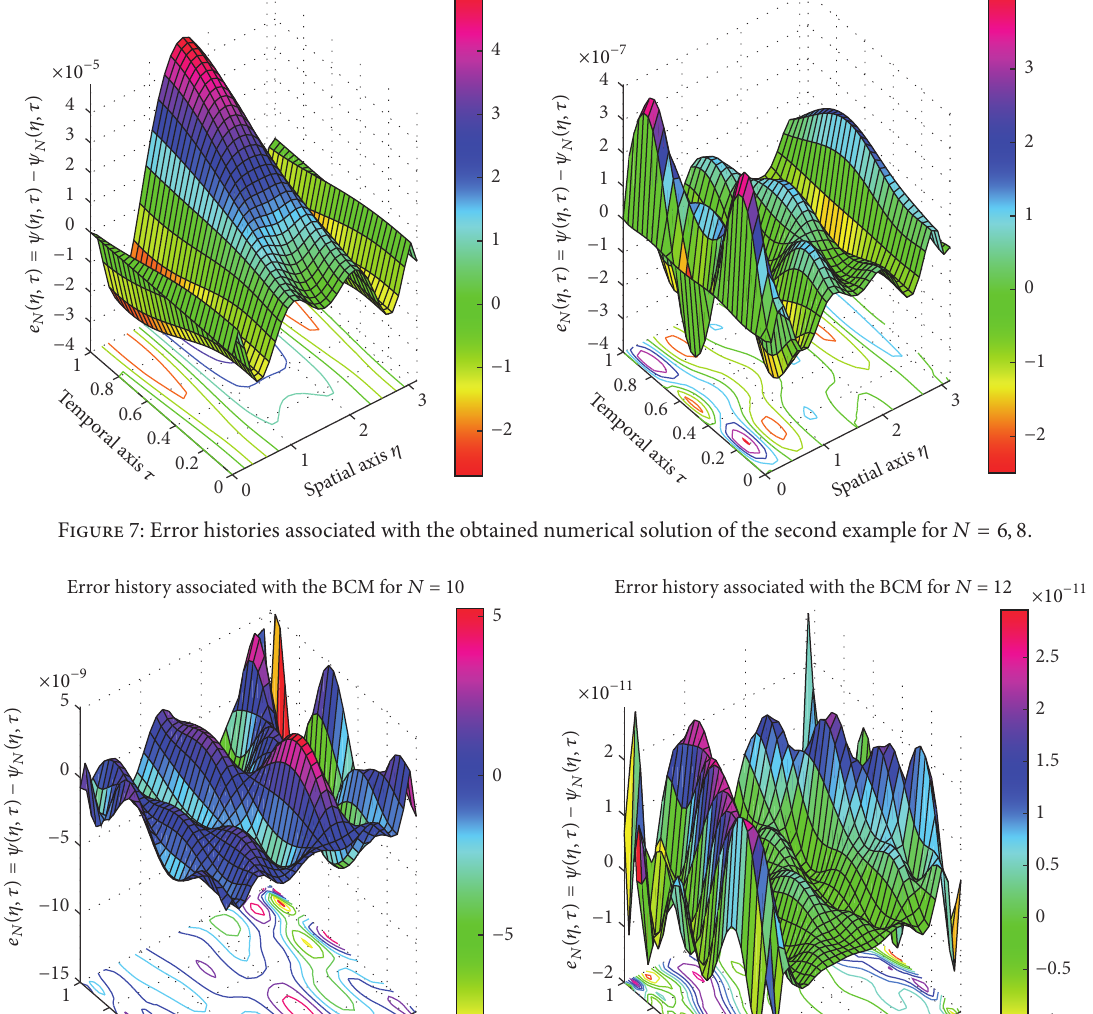
with the exact solution 𝜓(𝜂, 𝜉, 𝜏) = exp (𝜂 + 𝜉 + 𝜏) in